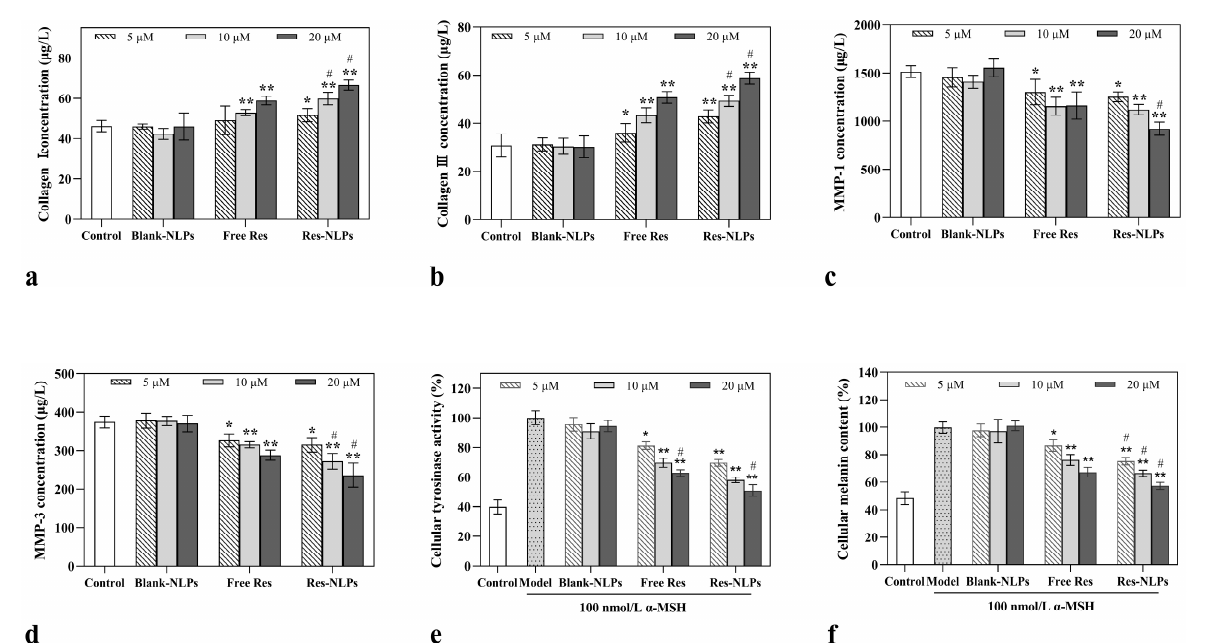
Figure 6. The anti-aging and skin-brightening effects of Res at the cellular level. ( a ) Collagen I, ( b ) collagen III, ( c ) MMP-1 and ( d ) MMP-3 secreted by HSF cells without treatment (served as the control group), or treated with the blank NLPs (equal lipid concentration as the Res-NLPs), the free Res or the Res-NLPs with various Res concentrations for 24 h. Inhibition of ( e ) tyrosine activity and ( f ) melanin production in B16F10 cells treated with DMEM only (served as the control group), blank NLPs (equal lipid concentration as the Res-NLPs), the free Res or the Res-NLPs with various Res concentrations for 24 h. Except for the control group, B16F10 cells in all groups were both treated with 100 nM α -melanocyte-stimulating hormone ( α -MSH). B16F10 cells treated with α -MSH only served as the model group. Mean ± SD ( n = 3). * p < 0.05, ** p < 0.01, compared with the control group (In Figure 6e, f: compared with the model group); # p < 0.05, compared with the free Res group.